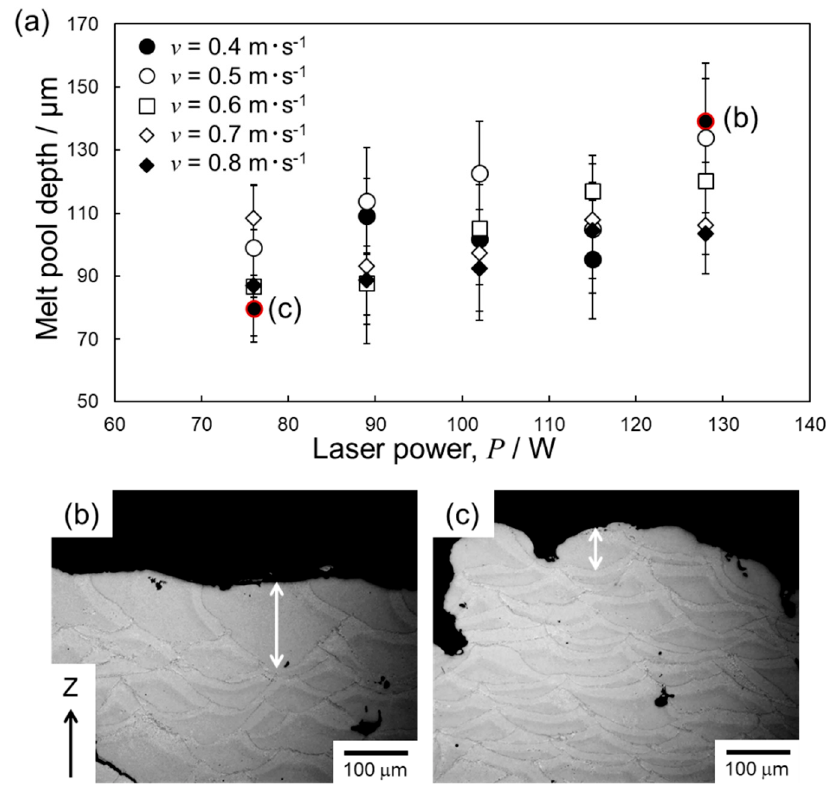
Figure 6. ( a ) Change in the melt pool depth of L-PBF-built Al–15%Fe alloy samples depending on the laser condition. ( b , c ) Melt pool morphologies observed on the surface of samples built under ( b ) 128 W–0.4 m·s –1 and ( c ) 77 W–0.4 m·s –1 . ( b ) 128 W–0.4 m · s − 1 and ( c ) 77 W–0.4 m · s − 1